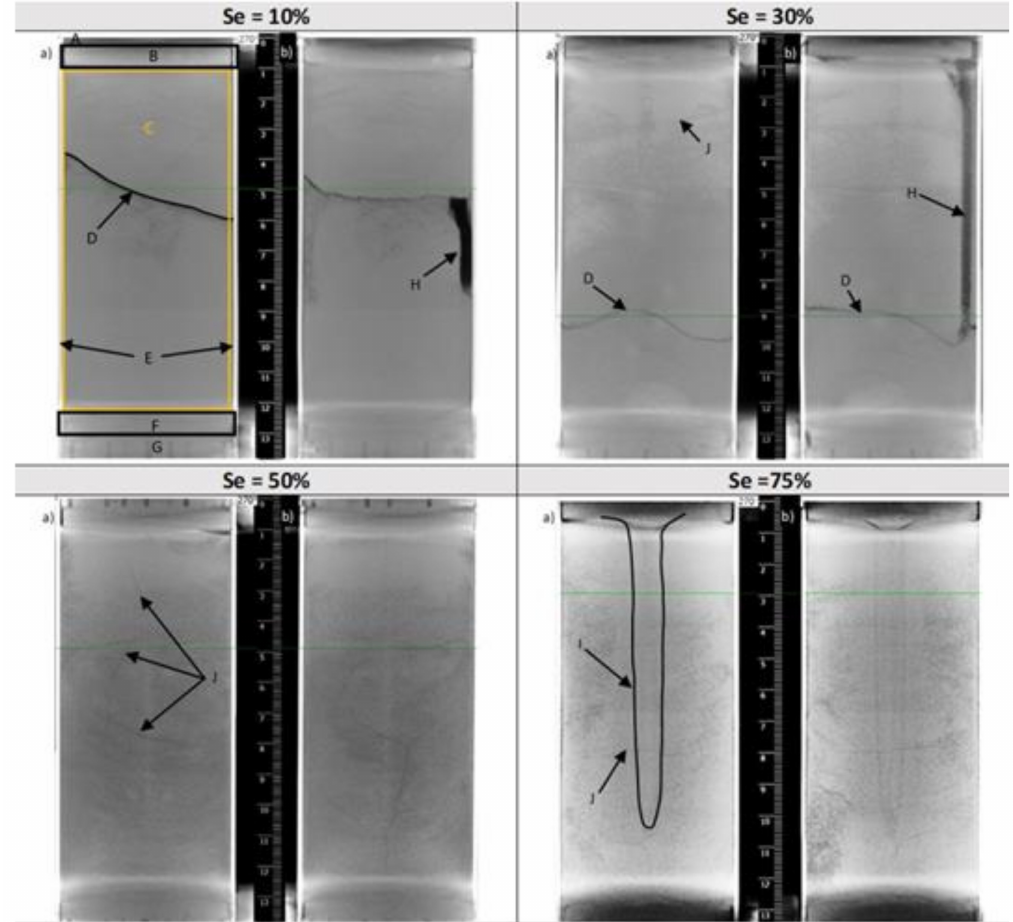
Figure 5. Orthogonal views of tomographic images of the sandy core for di ff erent water saturations (1) 10%, (2) 30%, (3) 50%, (4) 75%: ( a ) and ( b ) are orthogonal orientations. (A, E, G) Aluminum walls, (B, F) porous bauxite stones, (D) waterfront, (H) Thermometer hole, (I) high-water-content region, (J) cryogenic